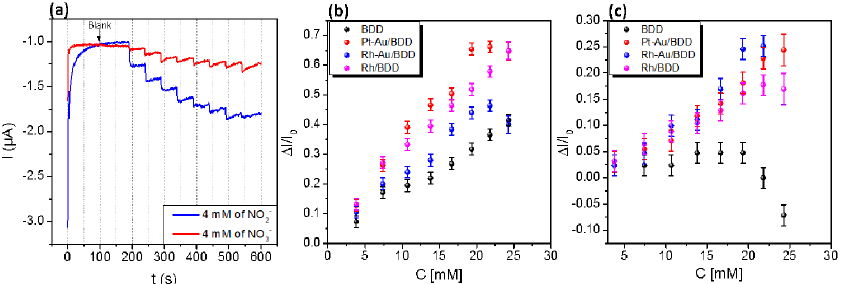
Figure 2. ( a ) Chronoamperometric response of Pt-Au/BDD electrodes for successive addition of 1 mL of 0.1 mM nitrite or nitrate solutions into continuously stirred aqueous medium (300 rpm) of 1 M of NaCl under a potential of—1V vs. (Pt.) with a volume of 25 mL; Calibration curve of nitrite ( b ) and nitrate ( c )